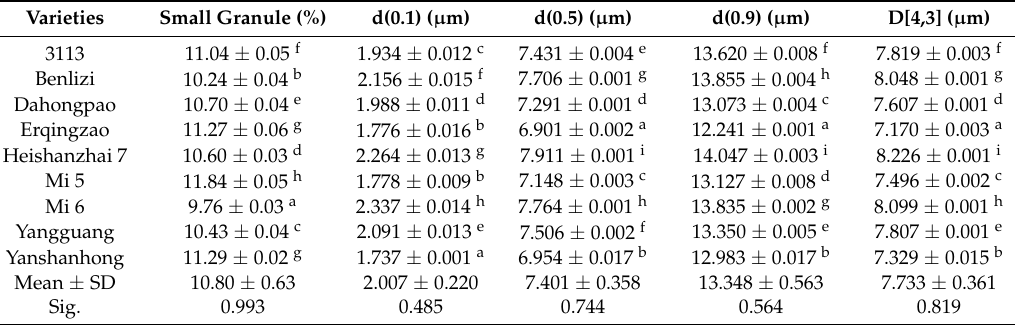
Figure 2. The morphology of starch granules from variety 3113 under normal light microscope ( A ), polarized light microscope ( B ), and scanning electron microscope ( C ). Scale bar = 10 µ m. Table 2. Volume percentage of small starch granules and starch granule size